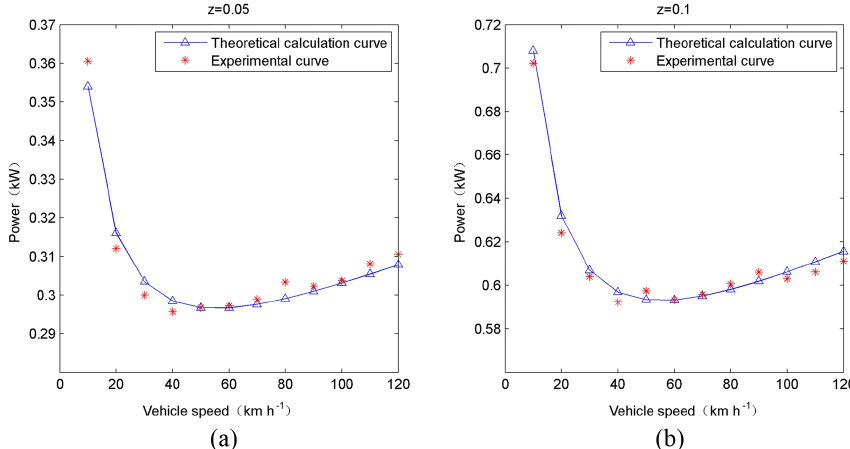
Figure 8. Curves of power consumption of electricity vary with vehicle